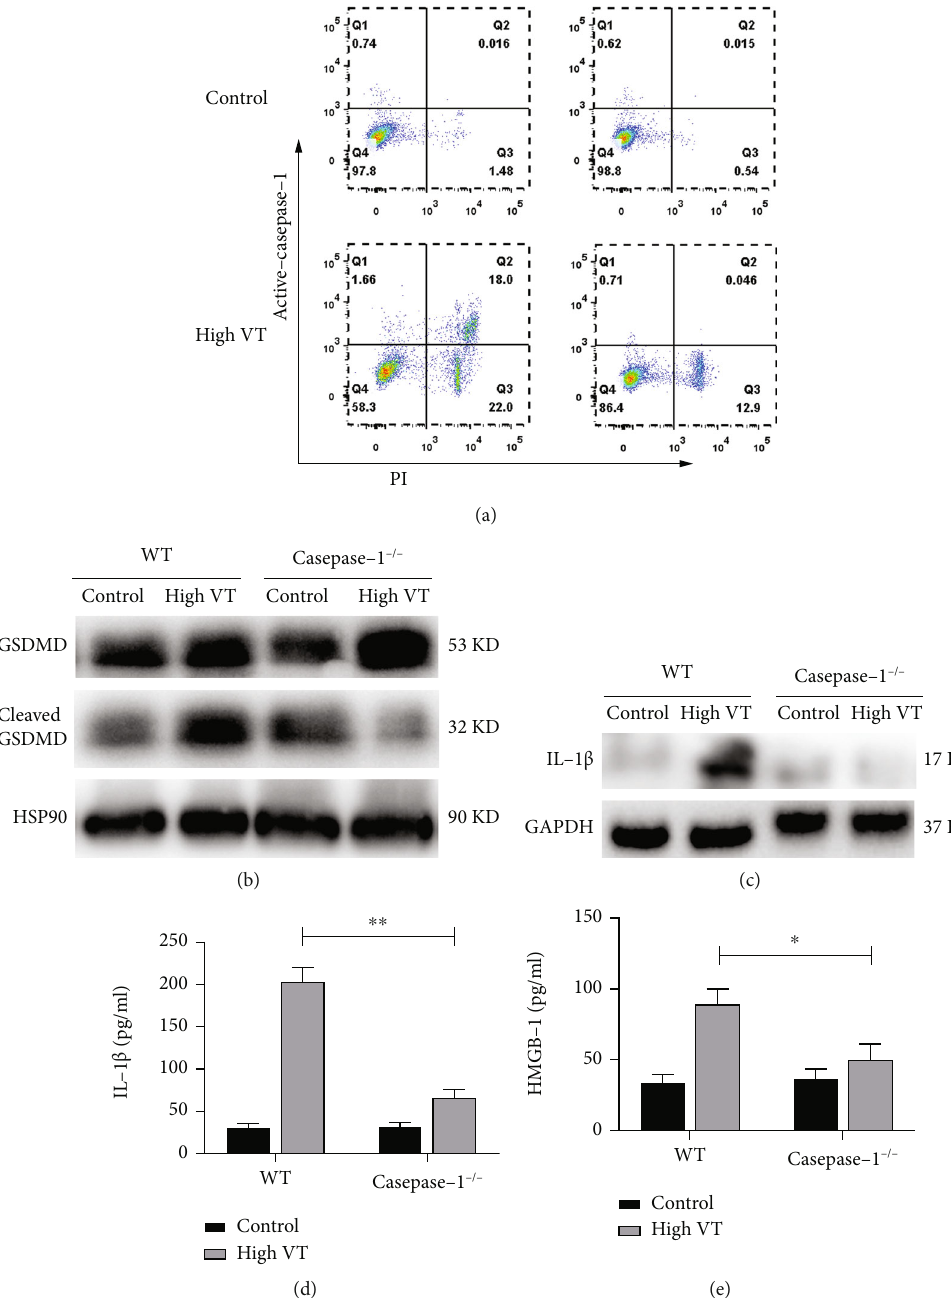
Figure 2: Caspase-1 deletion abolishes VILI and cytokine release in mice. (a) The fl ow cytometry showed caspase-1 deletion abolished death cells in alveolar macrophage. The protein level of GSDMD including full-length and cleaved forms (b) and mature IL-1 β (c) in alveolar macrophages was signi fi cantly decreased after caspase-1 knockout. Caspase-1 deletion attenuated pyroptosis-related cytokines in BALF of high VT, including IL-1 β (d) and HMGB-1 (e). Results are representative of three independent experiments; the results of one representative experiment are shown (n =5/group, ∗ p < 0 : 05 , ∗∗ p < 0 : 01